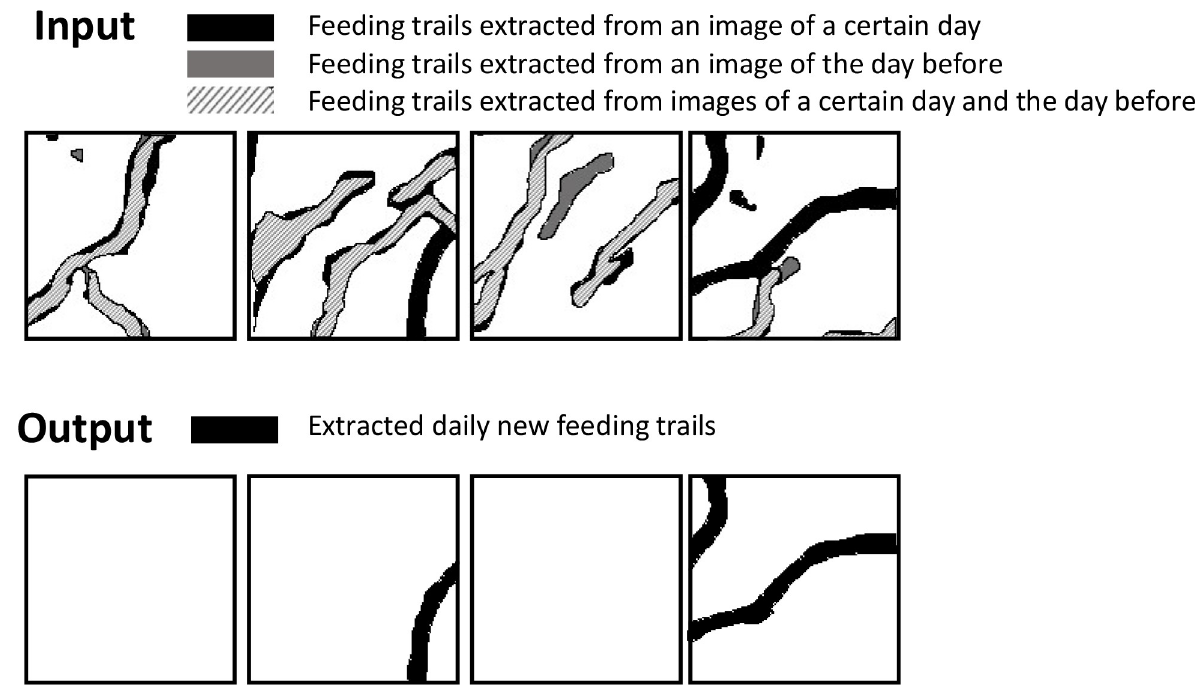
Fig 9. Examples of training data sets used for the extraction of the daily new feeding trails. Upper inset shows the input images. The black lines show feeding trails extracted only from an image of a certain day. The gray lines show feeding trails extracted only from an image of the day before. The striped lines show feeding trails extracted from both the image of a certain day and that of the day before. The lower inset shows the output images. The black lines in the lower inset show extracted daily new feeding trails.